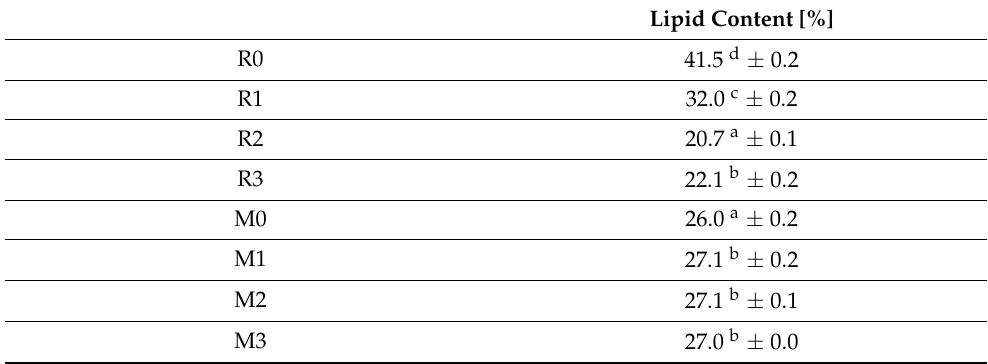
Table 1. Lipid content (%) and standard deviation of rapeseeds (R) and mustard seeds (M) during 3 days of germination. Values with different letters are significantly different ( p <